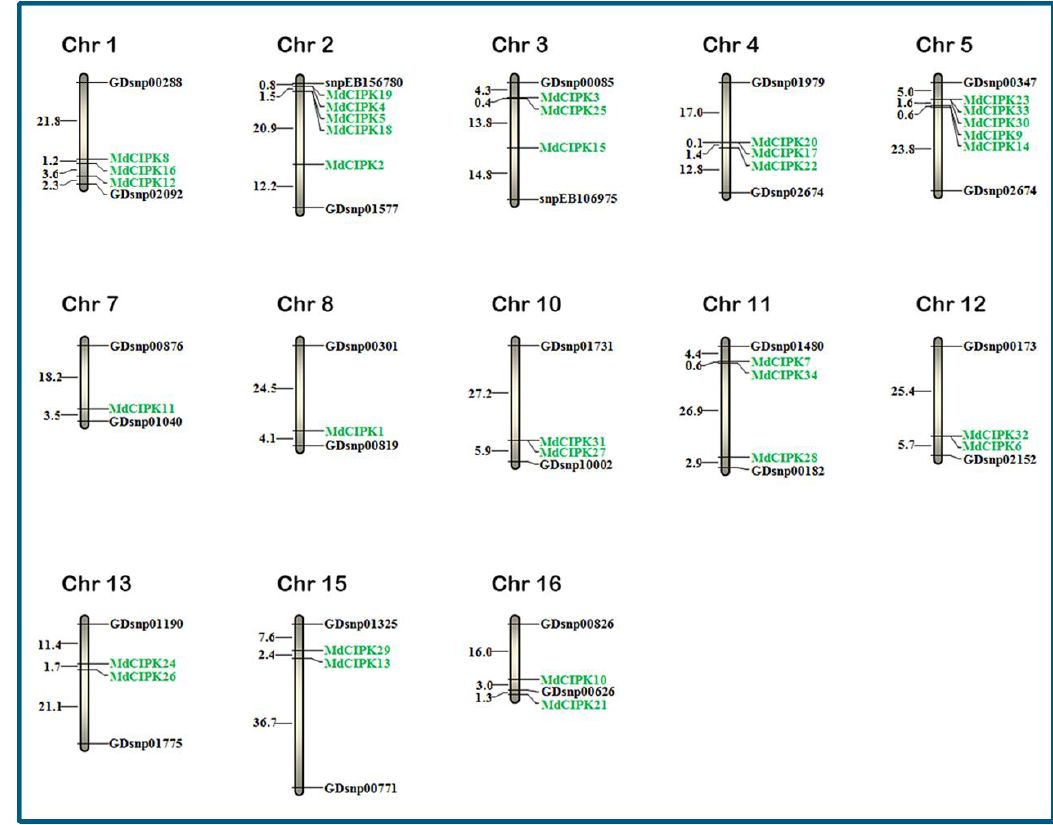
Figure 4. The distribution of MdCIPK genes in apple chromosomes (green color). There were 4 chromosomes that 6, 9, 14, and 17 chromosomes with no MdCIPK genes that not shown in this picture.